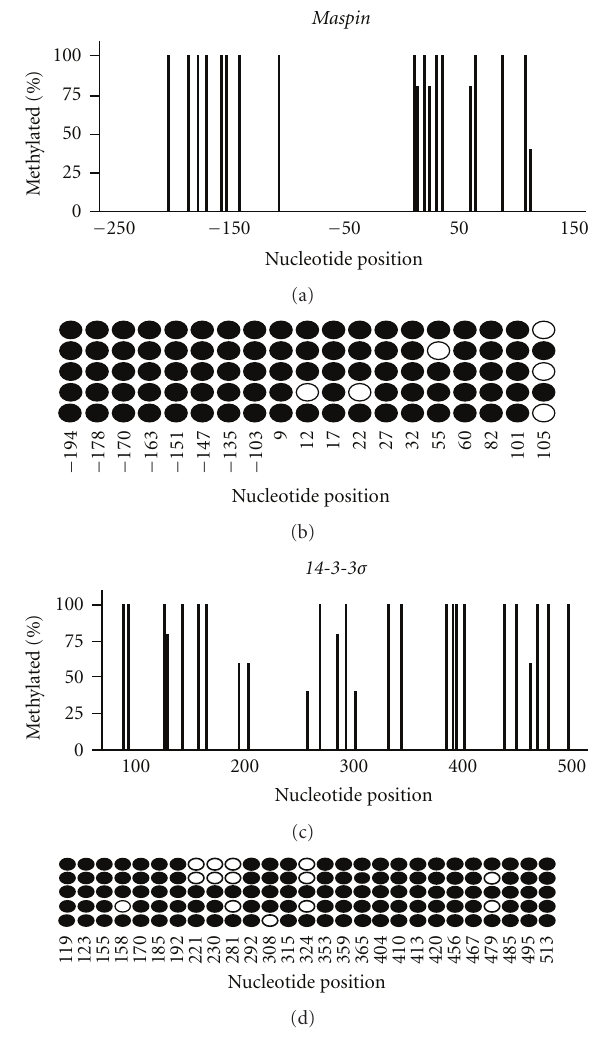
Figure 4: Normal chondrocyte cells have a highly methylated maspin promoter and 14-3-3 σ CpG island. (a) and (c) Histograms representing the percent methylation at each of the CpG’s spanning the maspin promoter and 14-3-3 σ CpG island in SNM83 chon- drocyte cells. (b) and (d) Bubble charts of Maspin and 14-3-3 σ in SNM83. Each of the five rows represents a sequenced amplicon, while each of the columns represents the position of the nucleotide relative to the transcription start site. Darkened circles represent methylated cytosines while open circles represent unmethylated cytosines. Nucleotide positions relative to start site were based on UCSC genome browser build